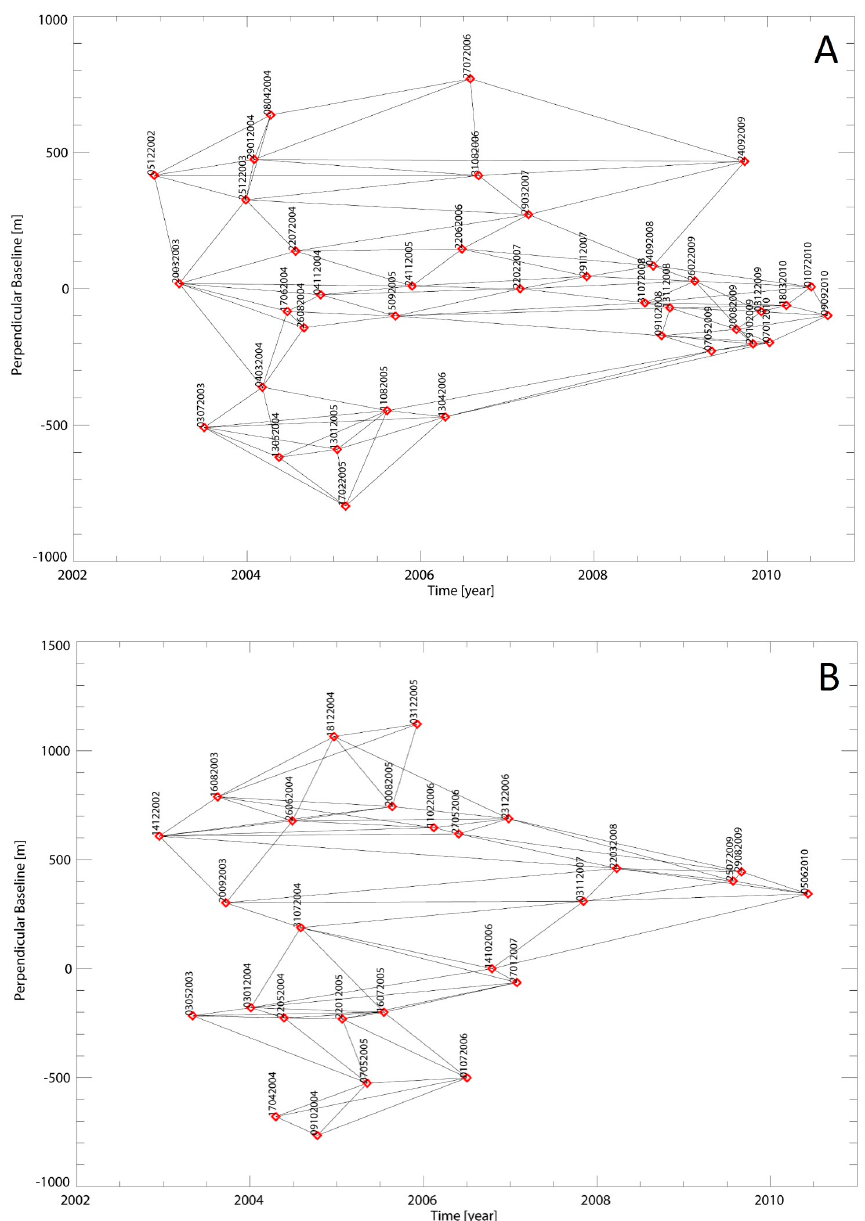
Figure 3. Distribution of ENVISAT acquisitions ( red points ), used in the SBAS processing, in the temporal ( x -axis)—perpendicular ( y -axis) baseline plane for the descending ( A ); and ascending ( B ) dataset. Black arcs show the computed interferograms.